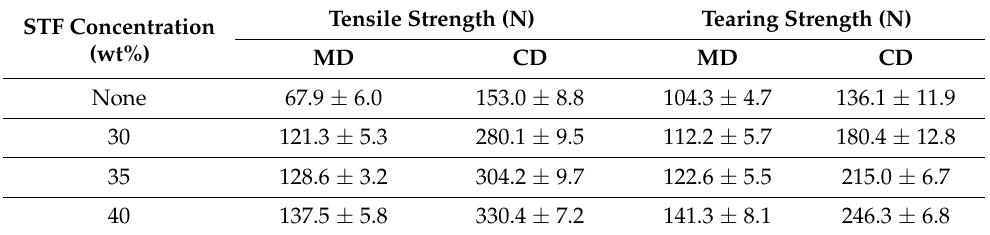
Figure 6. Tensile strength of STF composite nonwoven fabrics as related to the STF concentration. Table 2. Summary of tensile strength and tearing strength